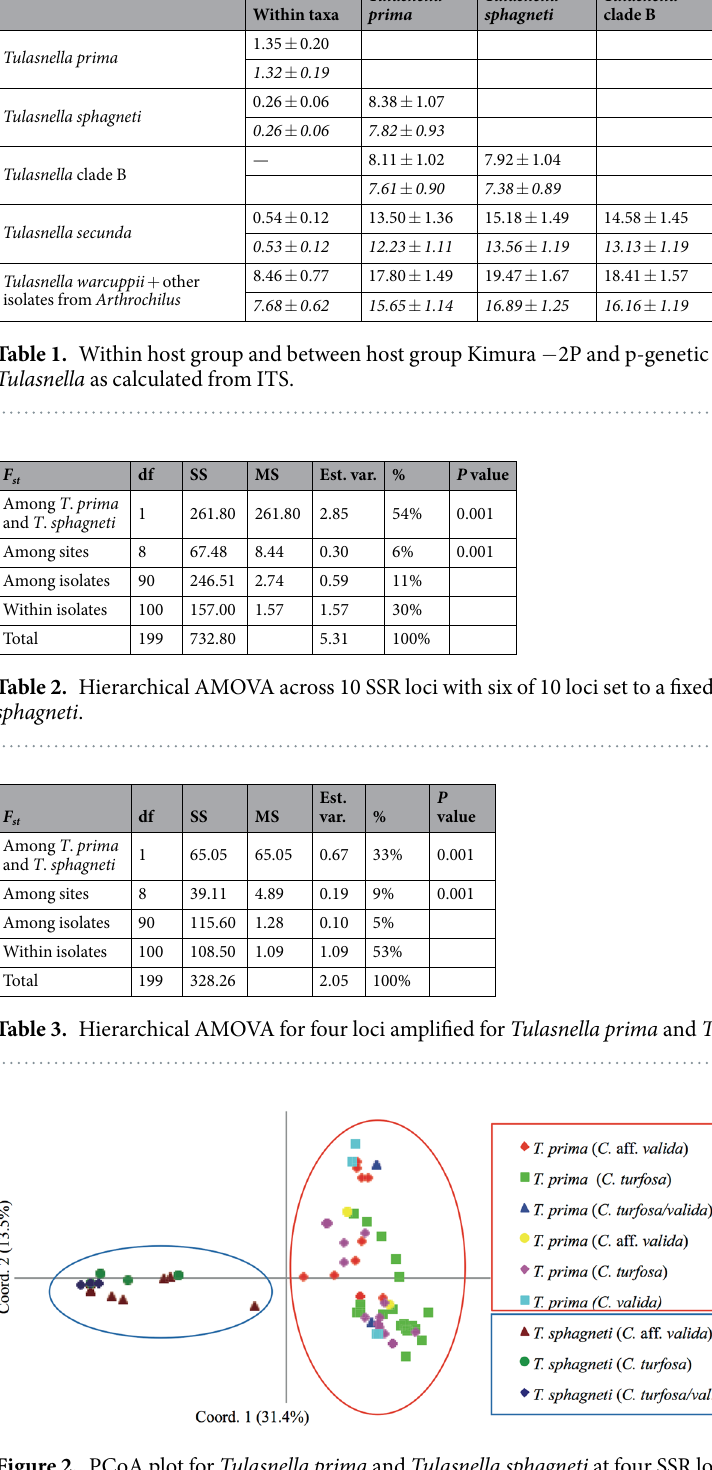
Figure 2. PCoA plot for Tulasnella prima and Tulasnella sphagneti at four SSR